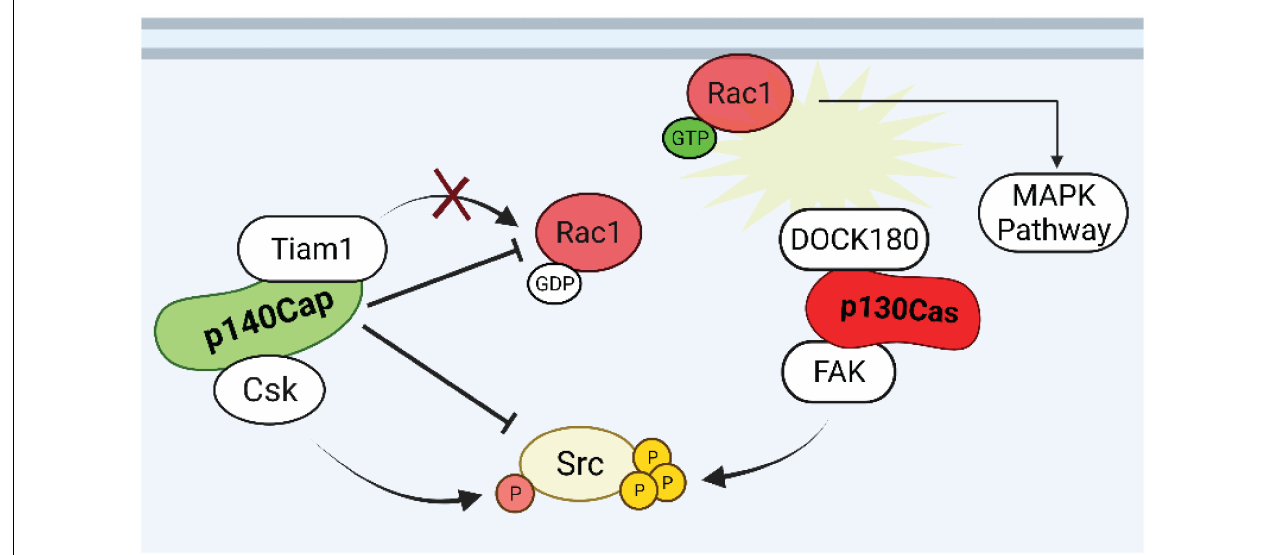
FIGURE 4 | Putative p130Cas and p140Cap points of crosstalk in breast cancer. Rac1 and Src are the possible points of crosstalk in which p130Cas and p140Cap may exert their antagonistic functions in the regulation of tumorigenic signaling. While Rac1 GTPase is kept inactive by p140Cap through the inhibition of the GEF Tiam1, the assembly of p130Cas/DOCK180 complex induces the recruitment of active Rac1 to the cell membrane. The p140Cap/CSK and p130Cas/FAK interactions contribute to the inhibition and activation of Src activity, respectively.